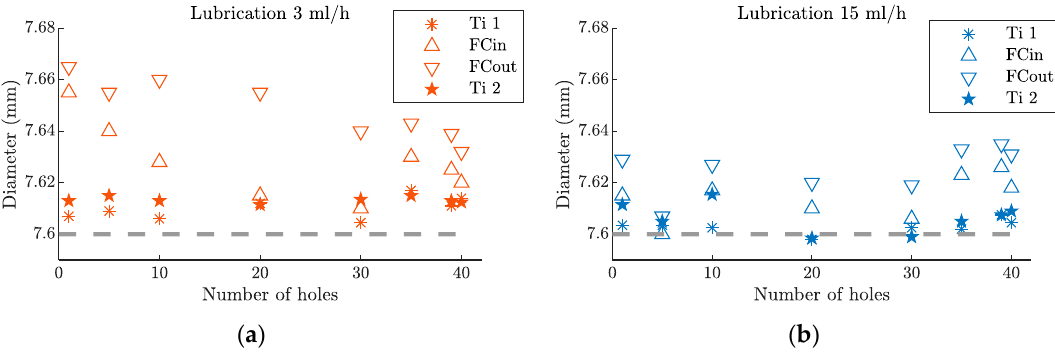
Figure 7. Hole diameter evolution, after 40 holes, in a hybrid Ti/CFRP/Ti stack. The dashed line represents the nominal diameter of the tool with ( a ) a lubrication level of 3 mL/h and ( b ) a lubrication level of 15 mL/h.